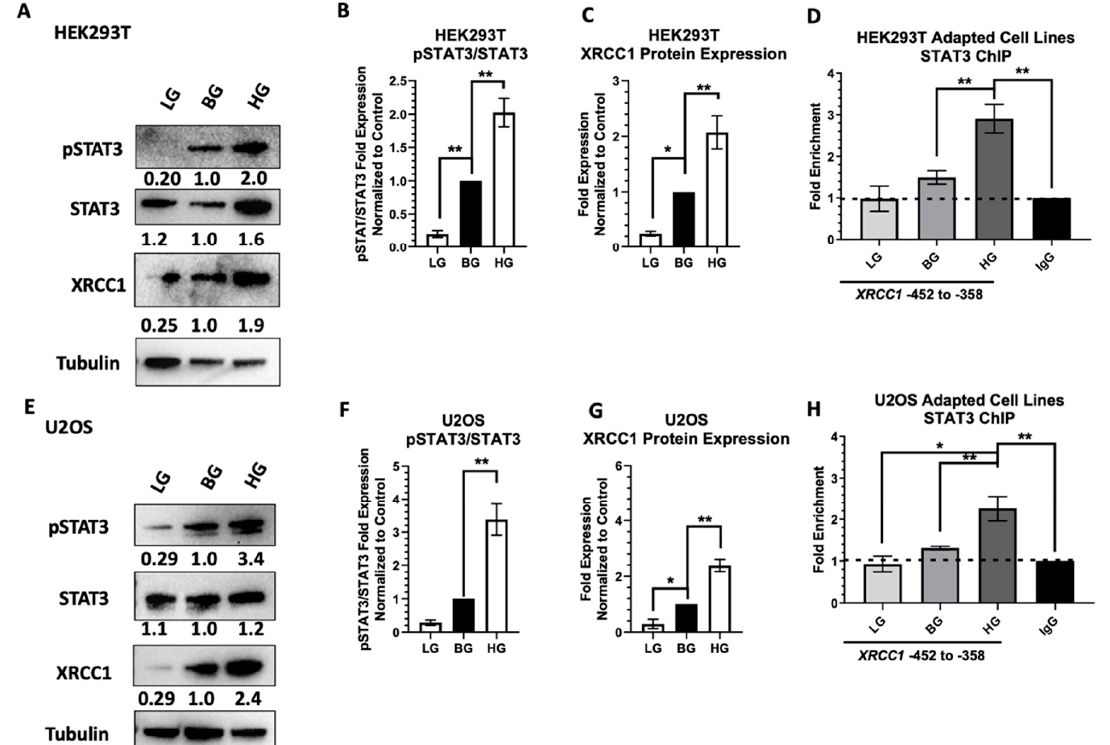
Figure 6. Alterations in XRCC1 expression following adaptation to different glucose concentrations. ( A ) Representative immunoblot of pSTAT3 and XRCC1 in HEK293T-adapted cell lines exposed to low glucose (5 mM, LG), basal glucose (25 mM, BG), and high glucose (30 mM, HG). ( B ) pSTAT3 relative to total STAT3 in HEK293T normalized to loading control then BG. ( C ) XRCC1 protein expression in HEK293T glucose-adapted cell lines normalized to BG. ( D ) ChIP analysis of STAT3 occupancy of at the XRCC1 promoter in glucose-adapted HEK293T cell lines normalized to respective IgG controls. ( E ) Representative immunoblot of pSTAT3 and XRCC1 in U2OS-adapted cell lines LG (5 mM), BG (11 mM), and HG (30 mM). ( F ) pSTAT3 relative to total STAT3 in U2OS normalized as in B. ( G ) XRCC1 protein expression in U2OS glucose-adapted cell lines normalized to BG. ( H ) ChIP analysis of STAT3 occupancy of the XRCC1 promoter in glucose-adapted U2OS cell lines normalized to respective IgG controls. * p < 0.05, ** p < 0.01.